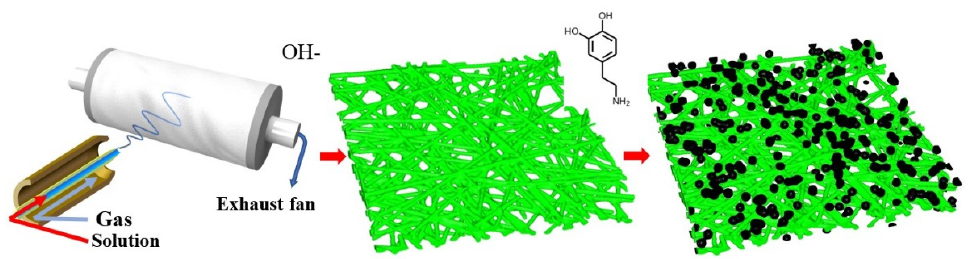
Figure 6. Schematic illustration of the formation process of the nanofiber